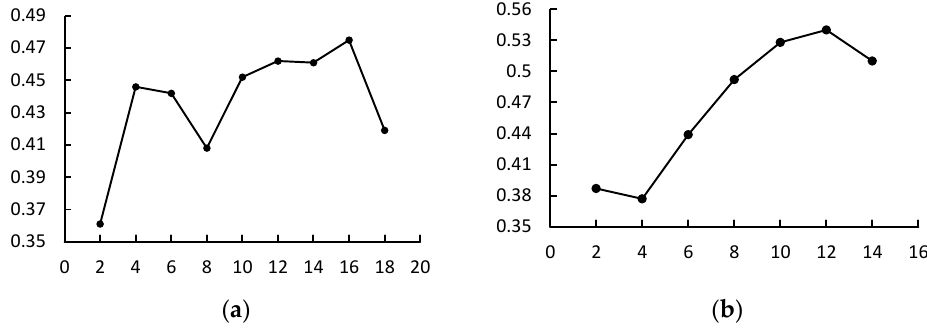
Figure 6. This is the subject consistency of T1 time slice data in the two domains: ( a ) is the subject consistency score of source domain T1 time slice data; ( b ) is the subject consistency score of target domain T1 time slice data.